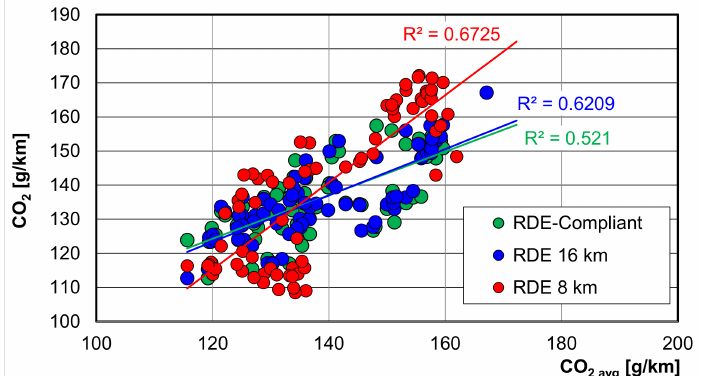
Figure 5. Comparison of road CO 2 emissions in each road test (RDE-Compliant, RDE 16 km and RDE 8 km) according to the road emissions averaged from all tests CO 2